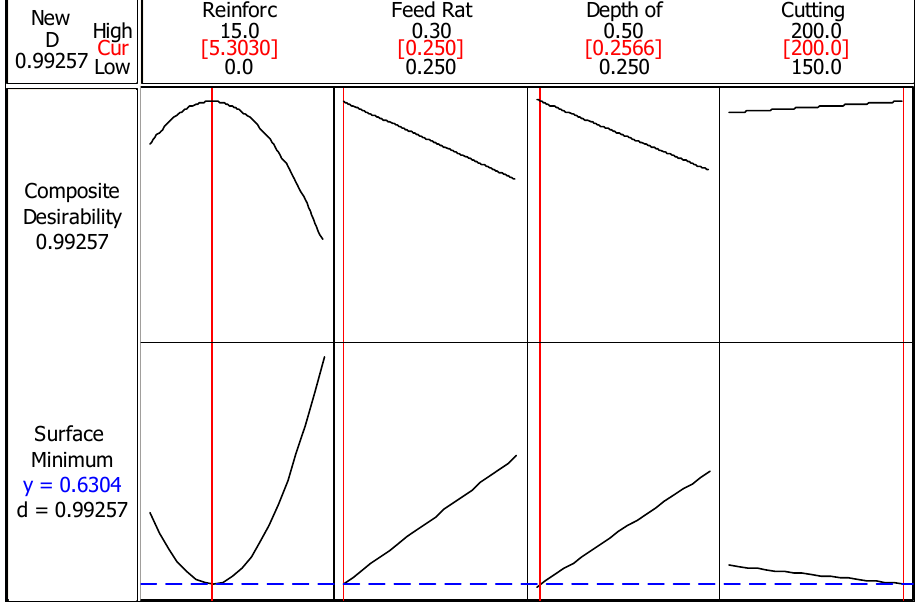
Figure 3. Main effect plots for S/N ratios of surface roughness.